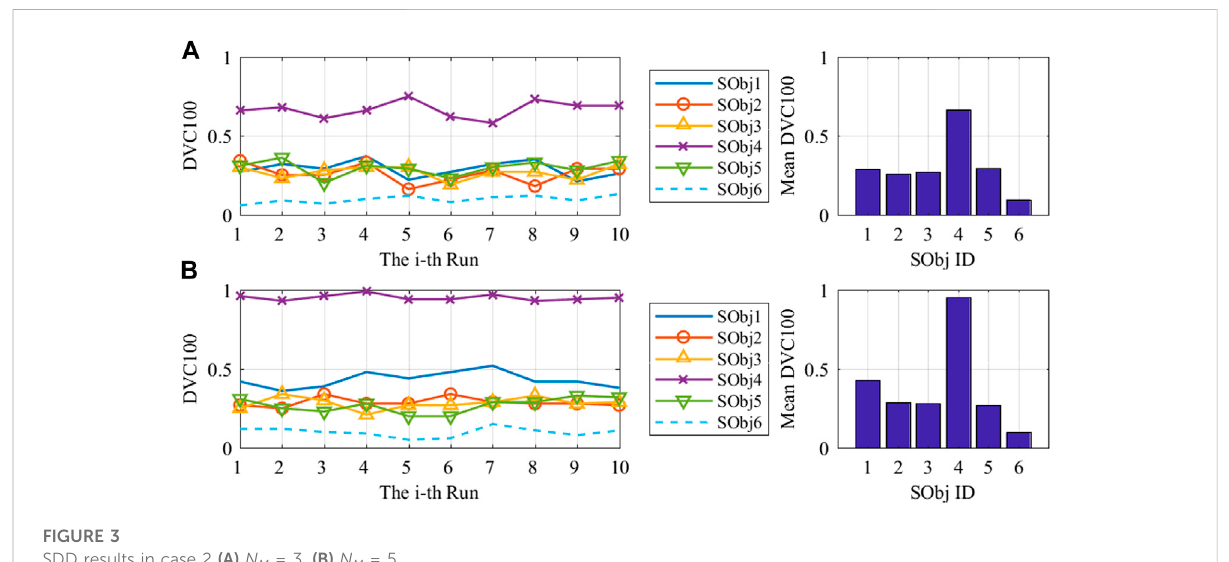
FIGURE 3 SDD results in case 2 (A) N M = 3. (B) N M = 5.